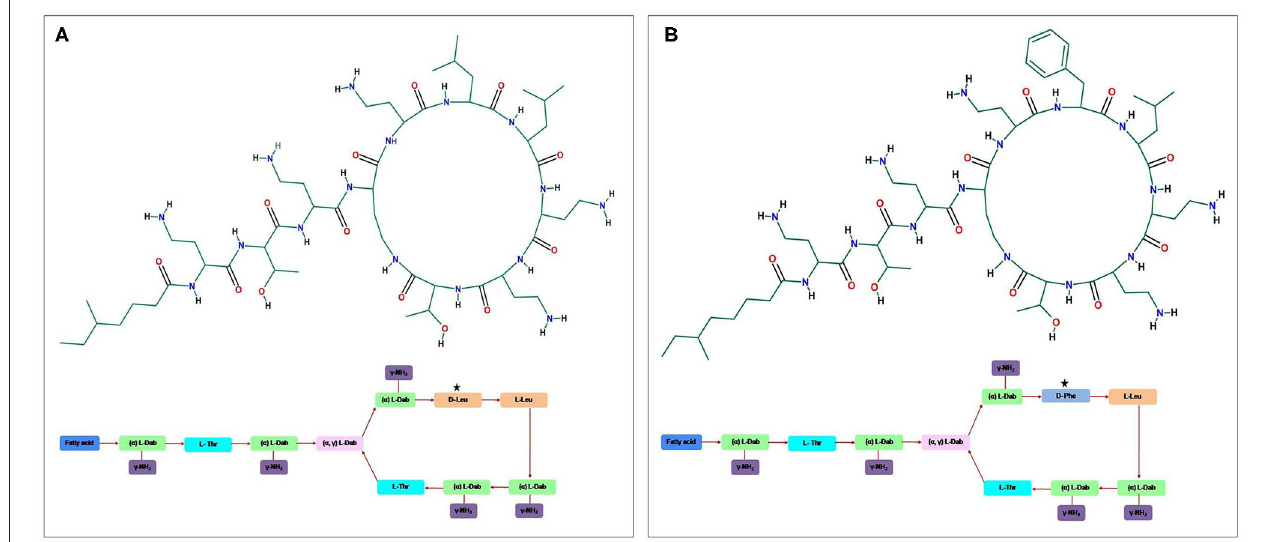
FIGURE 1 | The general structure of the cyclic cationic peptide (A) polymyxin E (colistin) and (B) polymyxin B, phenylalanine ( D -Phe) in polymyxin B peptide structure replaced with a leucine in